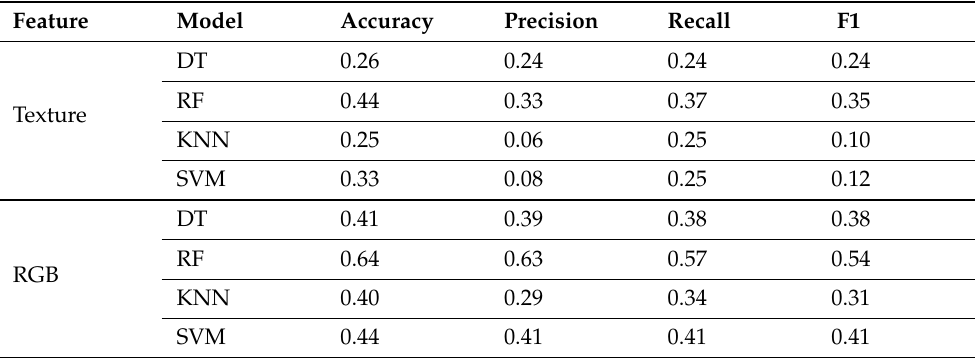
Table 9. Results of models on the augmented